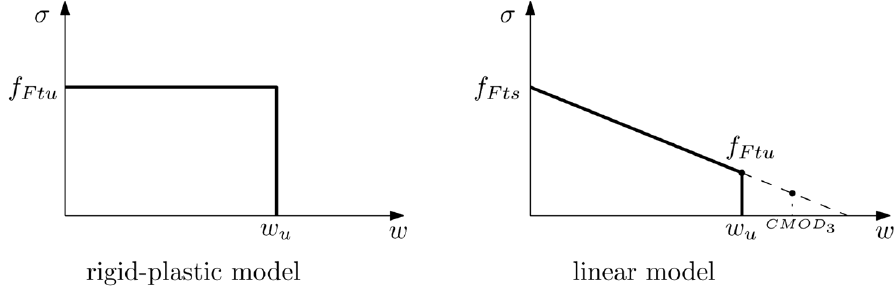
Figure 3. Rigid-plastic model ( left ) and linear model ( right ) as described by the MC2010.